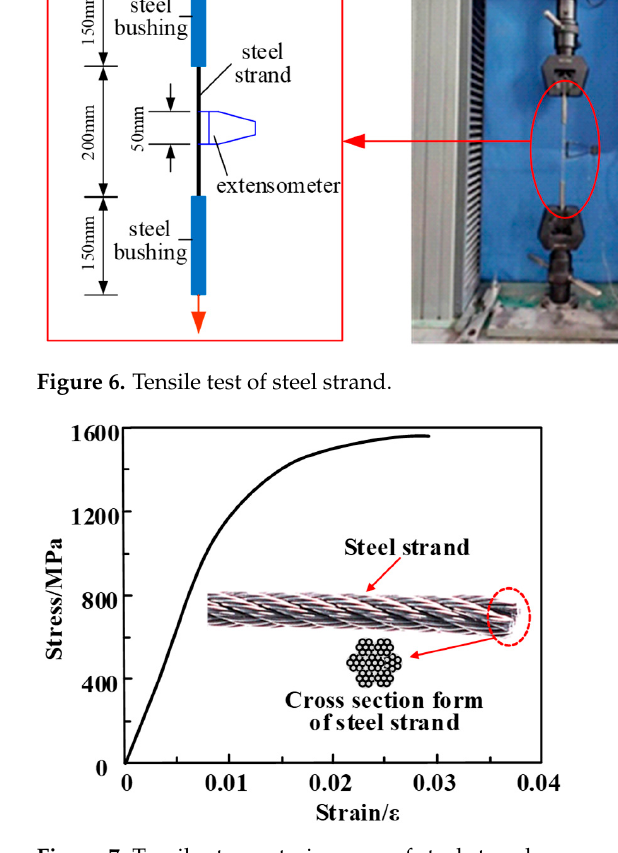
Figure 7. Tensile stress-strain curve of steel strand.